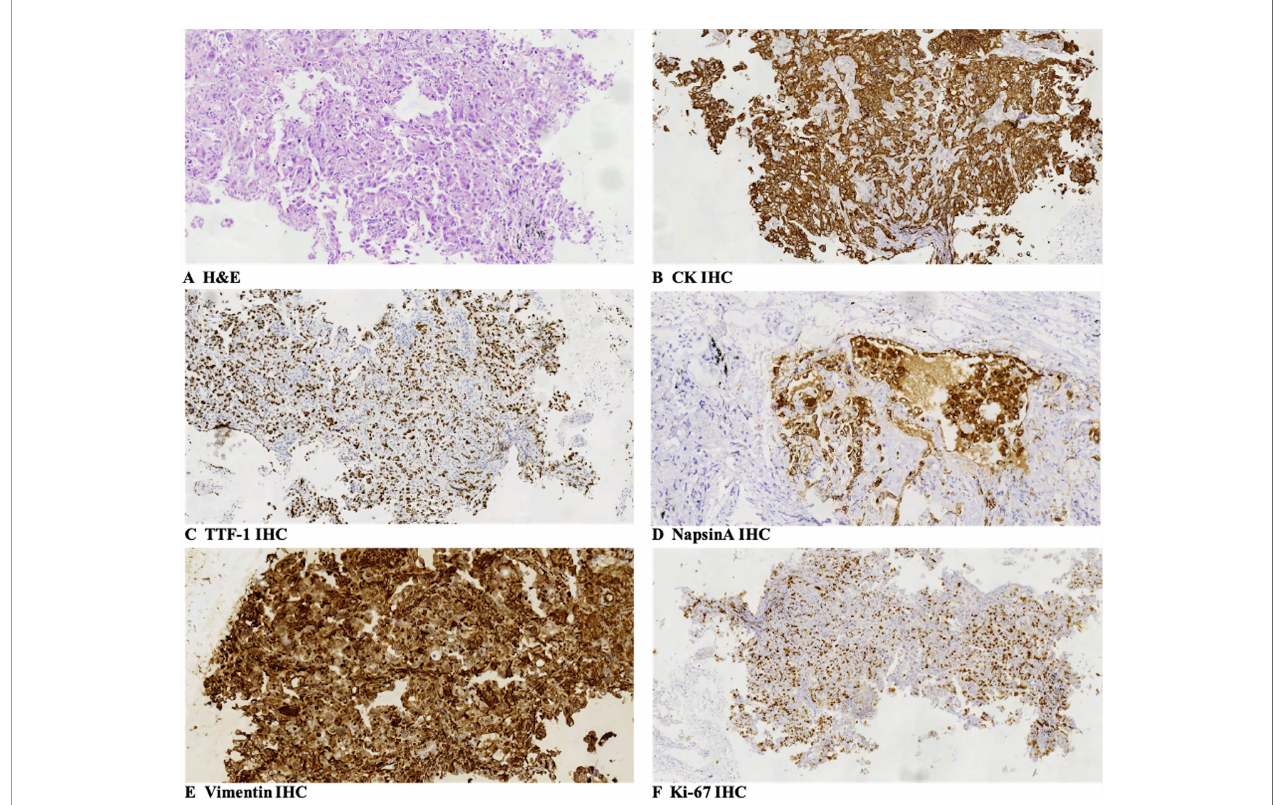
FIGURE 1 | Pathologic fi ndings: (A) the large-sized epithelioid tumor cells were arranged in a nest-like pattern, and they had wide cytoplasm with obvious atypia, large and clear cell nuclear, and nuclear fi ssion. The pathologic diagnosis of the biopsy specimens was poorly differentiated lung adenocarcinoma (H&E, SP ×200). (B – F) Immunohistochemical staining showed that tumor cells were positive for CK ( B , SP ×200), TTF-1 (focal positive, C , SP ×100), NapsinA ( D , SP ×200), and Vimentin ( E , SP ×200), and Ki-67 was 60% ( F , SP ×100). SP, streptavidin –